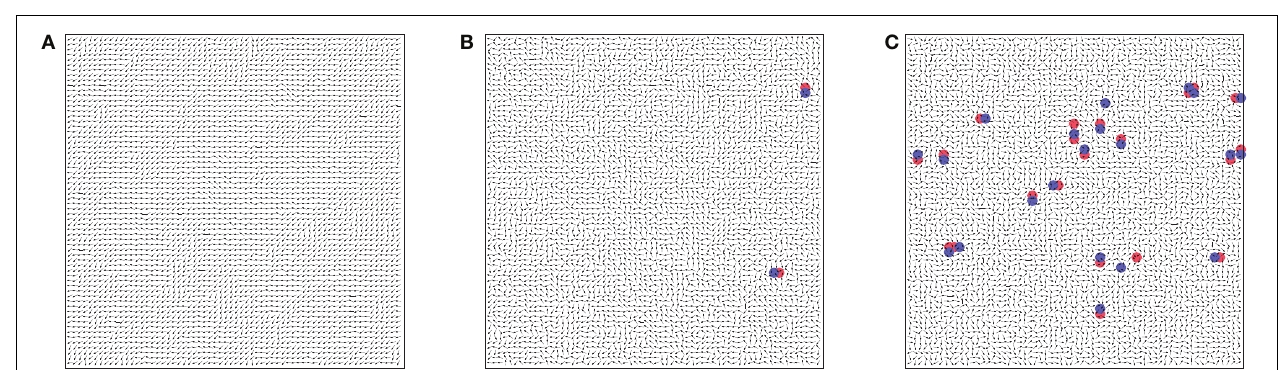
FIGURE 16 | (A) The x -component of a typical spin vector is plotted against time for lattice with L = 64 and n = 2 at zero noise. (B) The corresponding power spectrum indicates the presence of three basic frequencies